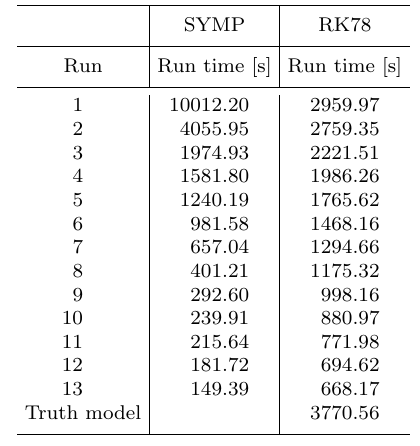
Table 2. Runtimes for each run.